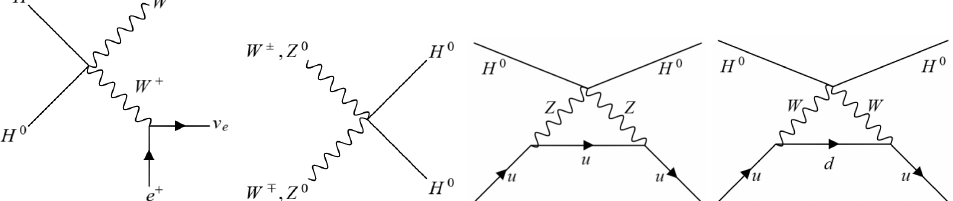
Figure 3. From left to right: (i) Example of annihilation into one real and one virtual W boson; there are 18 such processes for fermion-antifermion pairs (6 for leptons and 12 for the quarks with sufficiently low masses). (ii) Collider creation through vector boson fusion. (iii) and (iv) Scattering off a quark in an atomic nucleus through Z and W loop